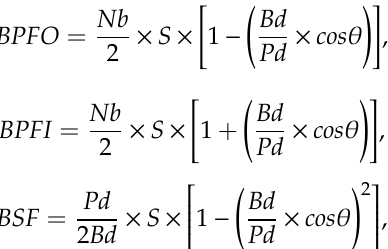
Table 1. The specification of the target bearing, FAG NJ206-E-TVP2.